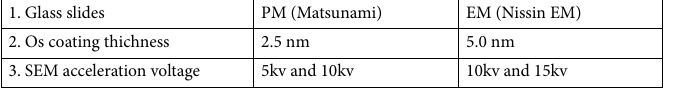
Table 1. Verified conditions for SEM